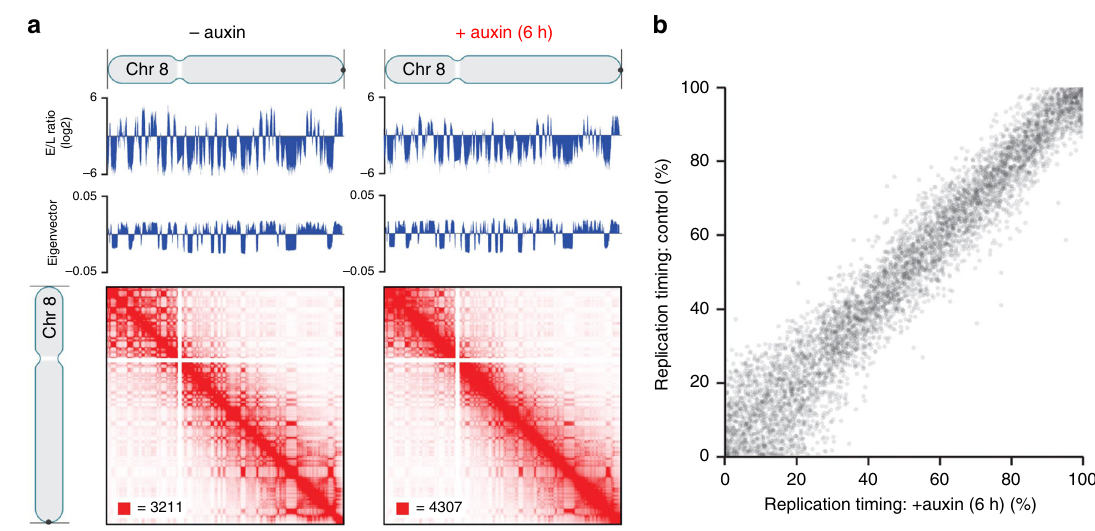
Fig. 7 Hi-C and Repli-Seq data demonstrate the same replication timing for cohesin depleted and non-depleted control cells. a Contact matrices of chromosome 8 at 500 kb resolution along with the corresponding Repli-Seq early-to-late (E/L) ratio tracks at 50 kb resolution and the fi rst eigenvectors of the Hi-C matrices corresponding to A/B compartmentalization. Replication timing along the genome is conserved, as shown by the correspondence of the untreated and auxin-treated Repli-Seq tracks. In addition, the correspondence between replication timing and genome compartmentalization (as indicated by the plaid pattern in the Hi-C map and the fi rst eigenvector of the Hi-C matrices) is preserved after auxin treatment. b Scatter plot of replication timing (percentile of E/L ratio) in RAD21-mAC cells before ( y -axis) and after ( x -axis) auxin